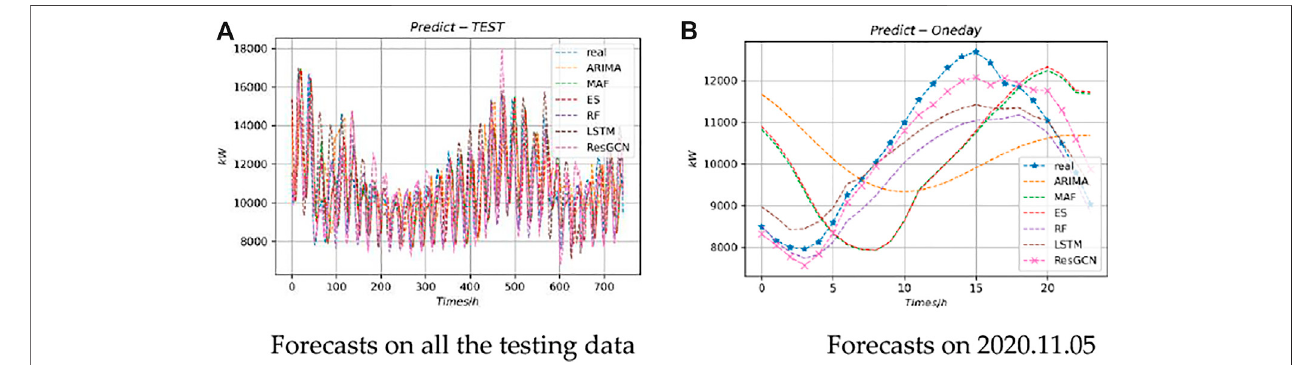
FIGURE 8 | Forecasts by different methods. (A) Forecasts on all the testing data; (B) Forecasts on 2020.11.05.